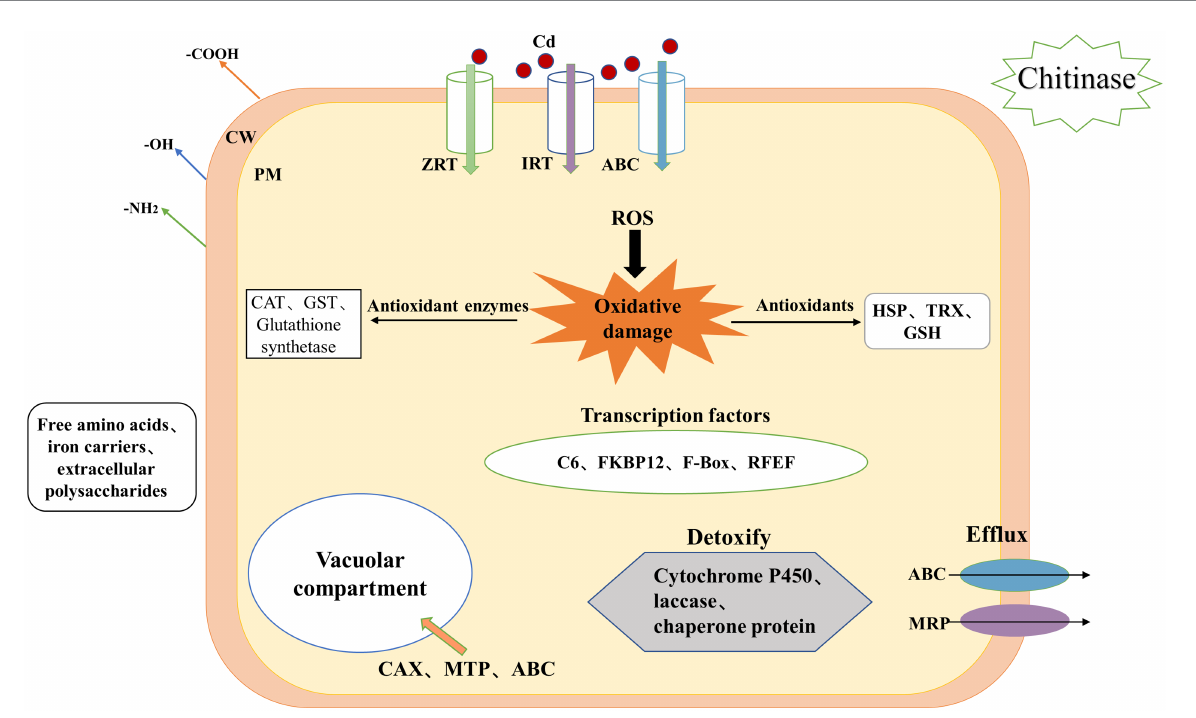
FIGURE 5 Mechanism underlying Cd accumulation and tolerance in H. chrysospermus cells. (CW: cell wall, PM: plasma membrane, Cd: cadmium, ROS: reactive oxygen species, ABC: ATP-binding cassette, ZRT: zinc-regulated transporter, IRT: iron-regulated transporter, MRP: multidrug resistance- associated protein, GSH: glutathione, HSP: heat shock protein, TRX: